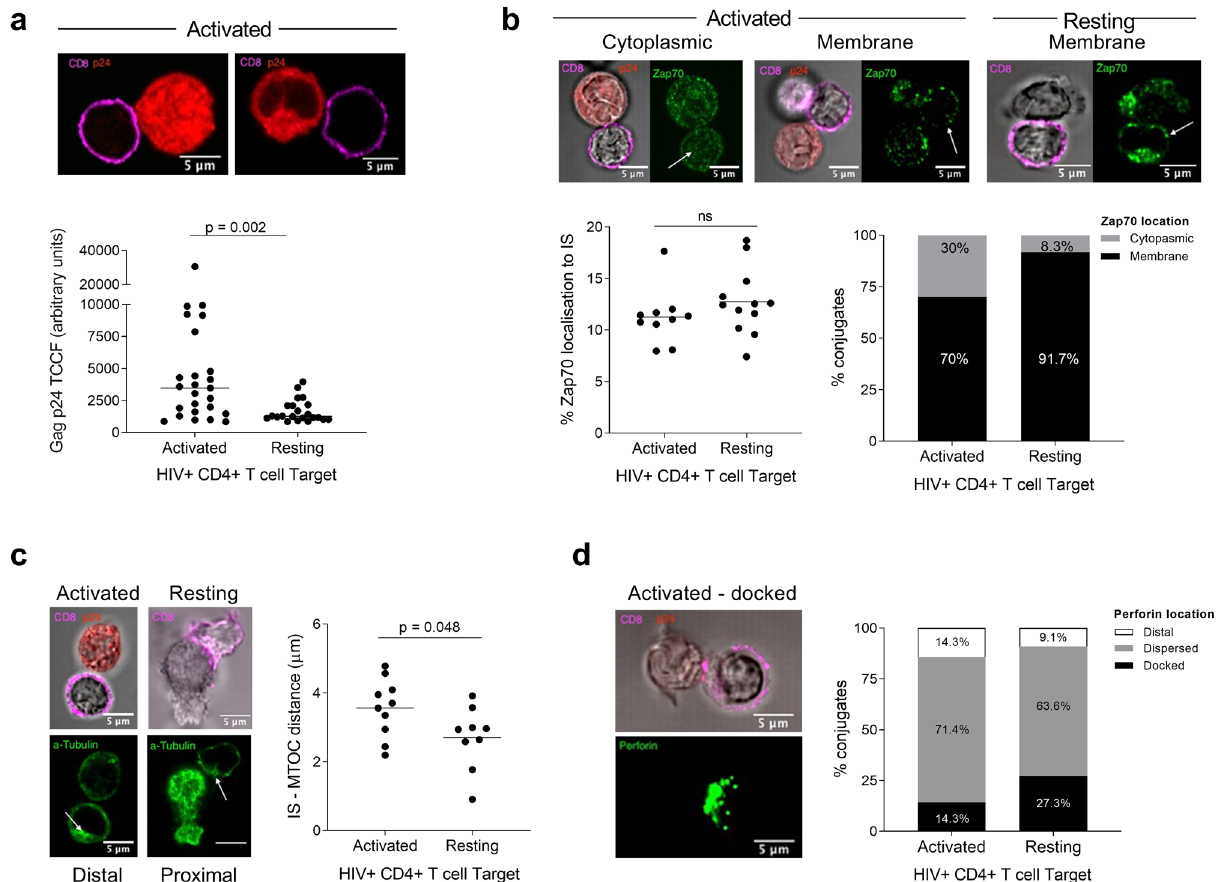
Figure 4. ImmTAV redirection of CD8 + T cells to HIV-infected primary CD4 + T cells. ( a ) Gag p24 total corrected cellular fluorescence (TCCF; as measured from confocal microscopy images) of activated or resting HIV-infected primary CD4 + T cells in conjugates with ImmTAV-redirected HIV-naïve donor CD8 + T cells (bottom); each dot represents a conjugate (n > 20/condition). Horizontal lines indicate median value. Groups were analysed by Mann Whitney test. Representative images of conjugates with activated infected CD4 + T cell targets shown as Gag expression in resting infected cells was not visible (top). ( b ) Confocal microscopy images of Zap70 localisation to the IS (examples of activated and resting, top), % Zap70 localisation at IS (bottom left) or cytoplasmic vs. membrane distribution (bottom right). ( c ) Confocal microscopy of α-tubulin (MTOC shown with white arrow; examples of activated and resting, left) and distance from MTOC to the synapse (µM, right). ( d ) Confocal microscopy of perforin localisation (docked example, left) and % of conjugates with distal, dispersed or docked perforin (right) in the CD8 + T cell. All synapse markers: at least 8 conjugates analysed per condition. Red = p24*, magenta = CD8 on DIC image, green = synapse molecule. For ( b )–( d ), horizontal lines indicate mean values. Groups were analysed by unpaired t test. *As p24 intensity in resting infected cells is very low and thus difficult to visualize, only DIC & CD8 signal images are